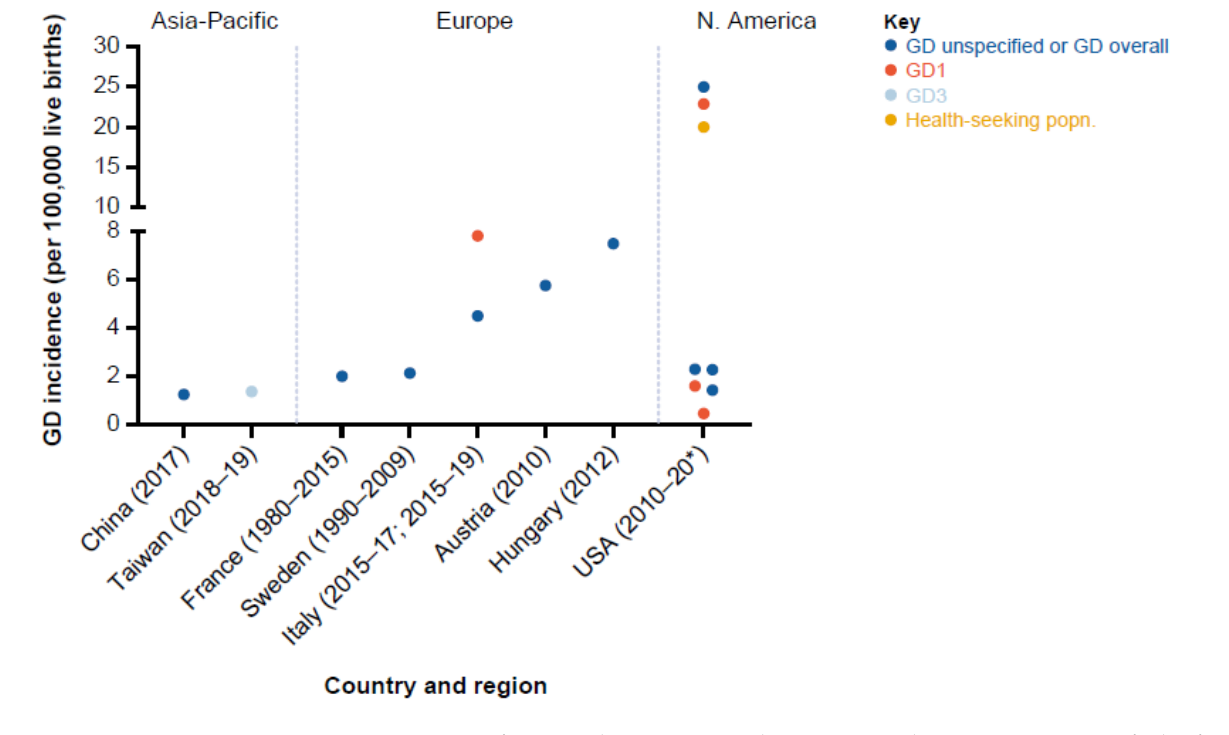
Figure 2. Summary of GD incidence estimates by country and region. GD unspecified refers to absence of any mention of whether study targeted GD overall or a given type. * For the eight data points from the USA (in ascending order), the corresponding time periods of study were: 2014–2016;